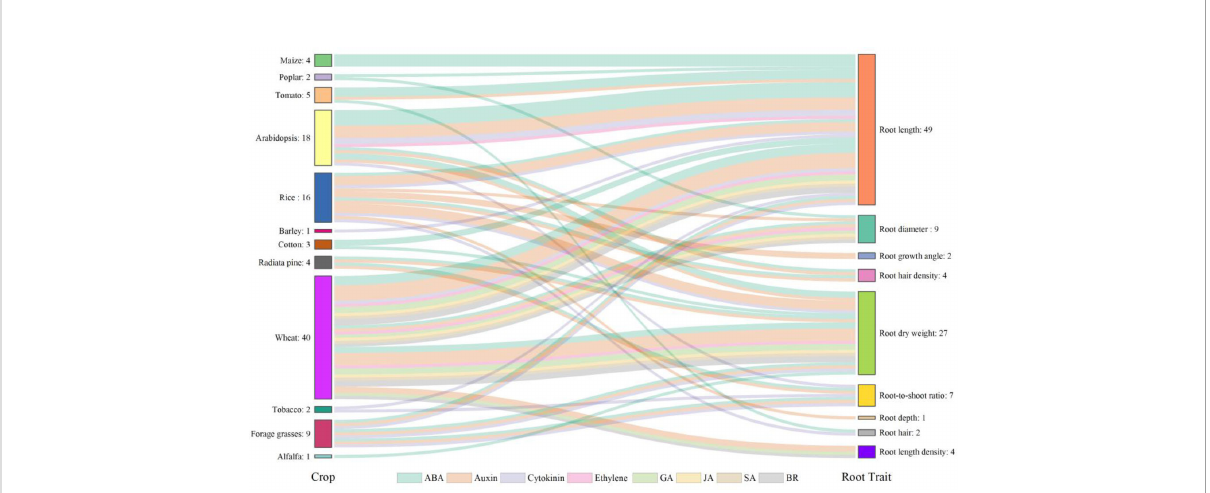
FIGURE 4 Hormones involved in the drought responses of root traits in different plant species reported in the literature. The numbers of observations are also shown. Crops are listed on the left-hand side and root traits on the right-hand side. Crops and root traits are connected by speci fi c fl ows in different colors representing different hormones involved. Data and references are included in Supplementary Table 2 and Supplementary File 2,